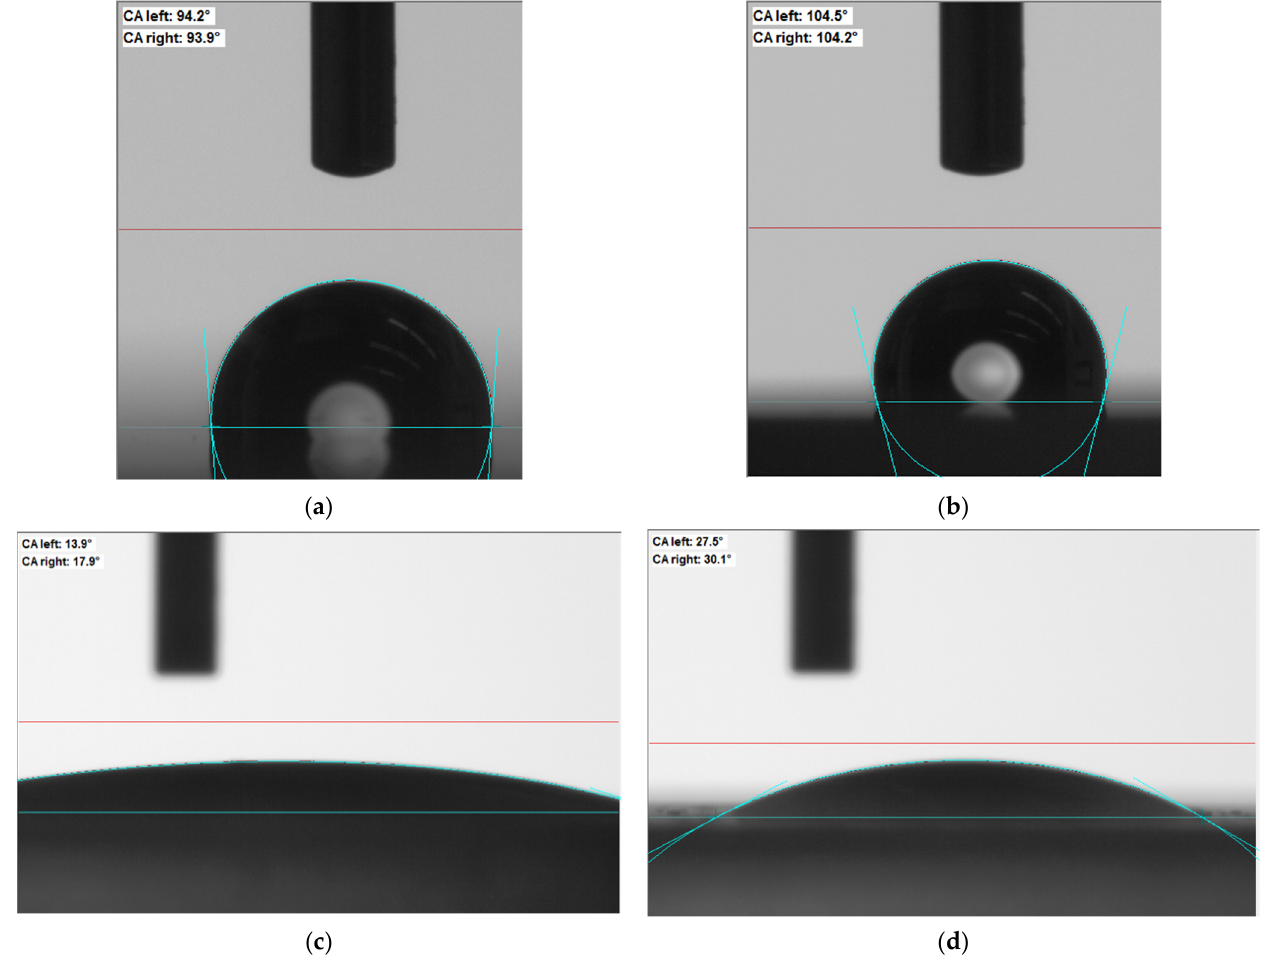
Figure 2. Wetting angle at the surfaces of: ( a ) pure PI (water drop); ( b ) PI with WS 2 NTs (water drop); ( c ) pure PI (LC drop); ( d ) PI with WS 2 nanotubes (LC drop).